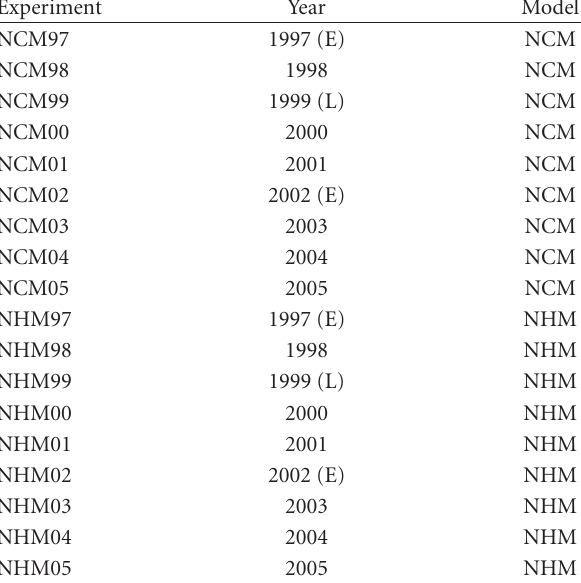
Table 1: Designations of the numerical-prediction experiments, the year used for the oceanic preexisting conditions, and the model, NCM and NHM, used to conduct the experiments. El Ni˜no years are followed by (E) and La Ni˜na years by